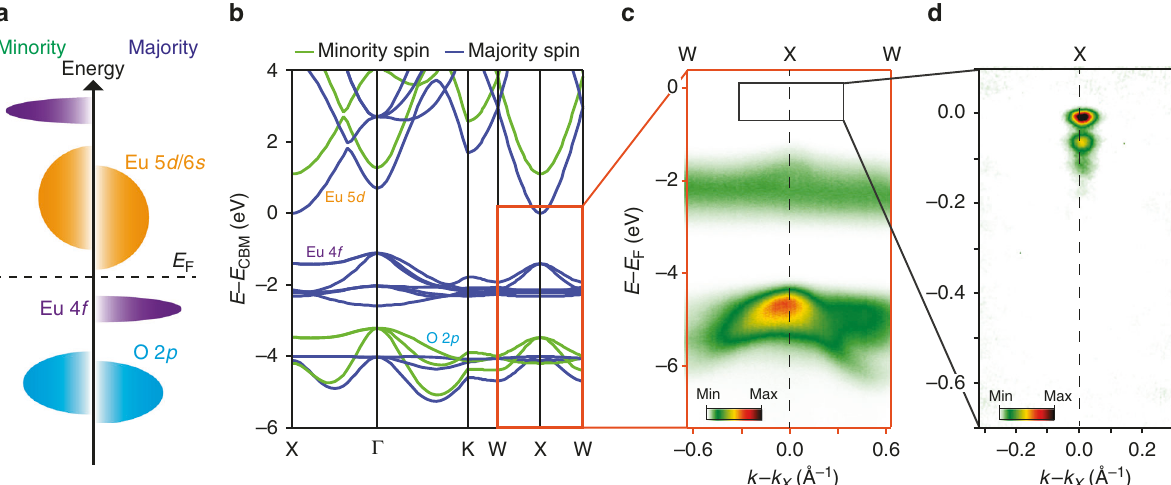
Fig. 1 Electronic structure of the ferromagnetic semiconductor EuO. a Schematic energy level diagram of EuO, with a half- fi lled Eu 4 f band split by strong Coulomb interactions yielding a band gap between Eu 4 f (5 d ) valence (conduction) bands. b DFT calculations of the electronic structure reproduce these general features and indicate the conduction band minimum (CBM) is located at the Brillouin zone face, X, point. c ARPES measurements ( h ν = 48 eV) from a lightly Gd-doped sample (Eu 1 − x Gd x O, x = 0.023) qualitatively match the DFT valence band dispersions. d The charge carrier doping additionally populates the spin-majority Eu 5 d conduction-band state at the X-point (region shown by black box in ( c